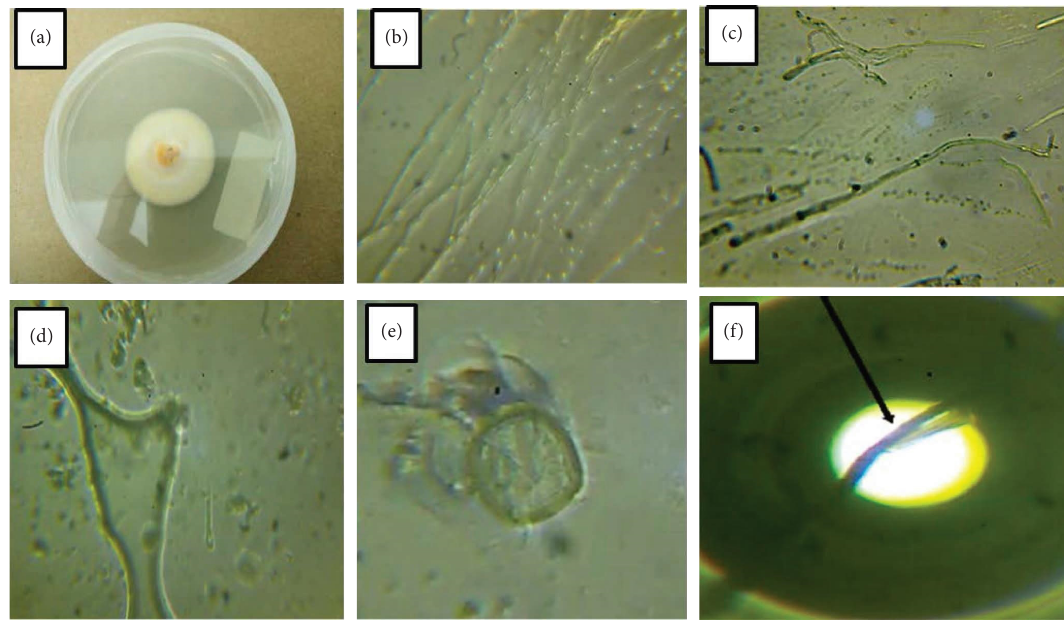
Figure 1: Macroscopic and microscopic characteristics of Lagenidium giganteum . (a) Colony on agar; (b) mycelium; (c) zoospores; (d) homothallic reproduction; (e) zygote; (f) stained